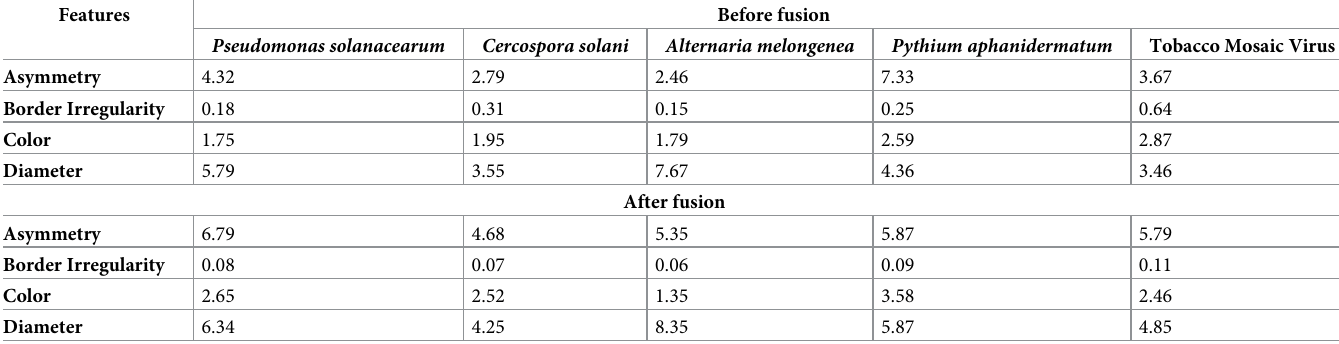
Table 6. Structural features based on DST.